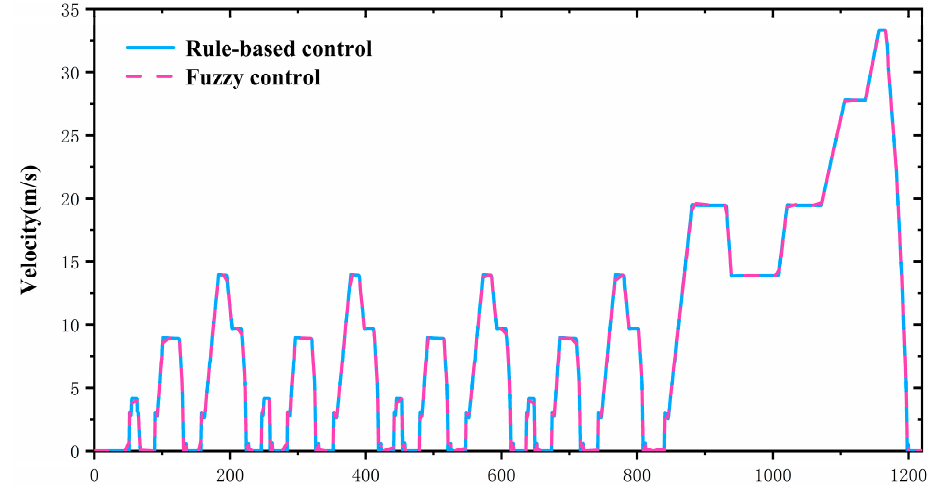
Figure 12. Fuzzy optimization analysis: speed curve.